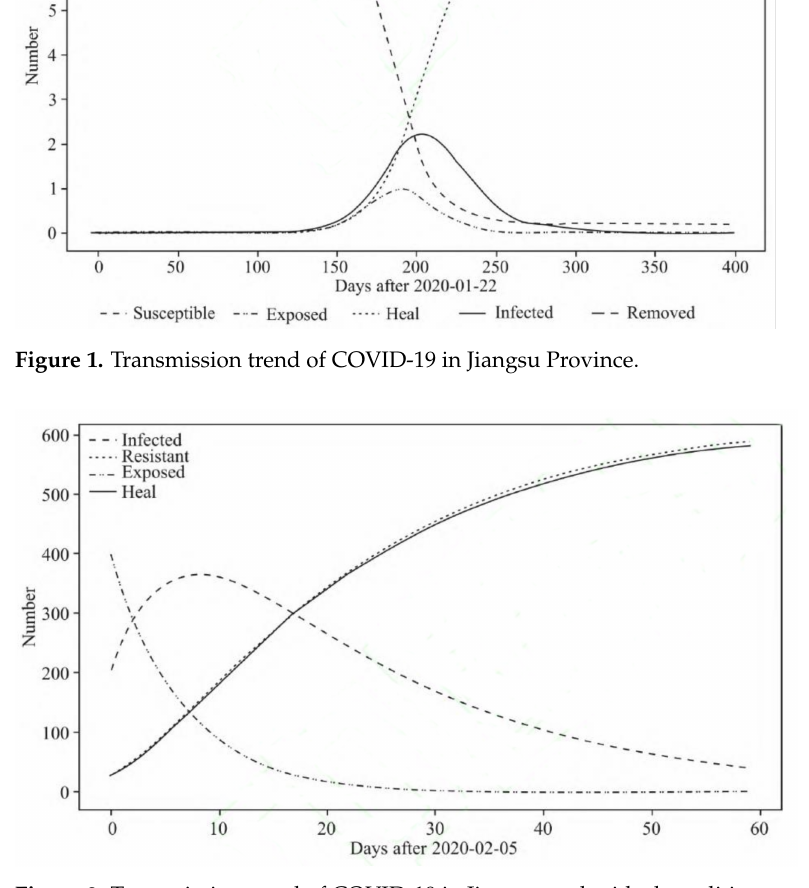
Figure 2. Transmission trend of COVID-19 in Jiangsu under ideal